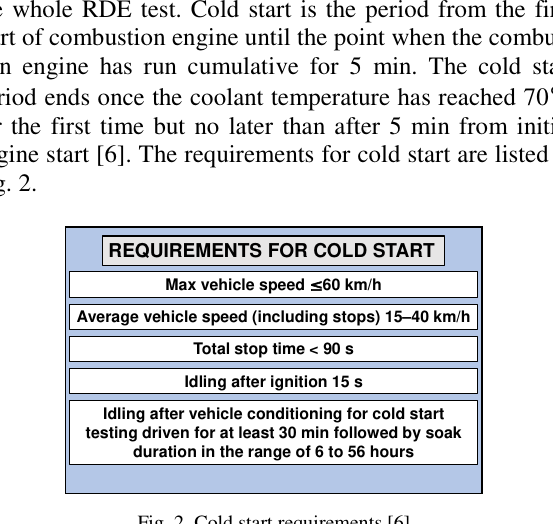
Fig. 2. Cold start requirements [6] Fig. 3. Diagram of the measurement system used for testing (a) and mobile exhaust gas analyzer with marked flue gas flow (b) for the measurement